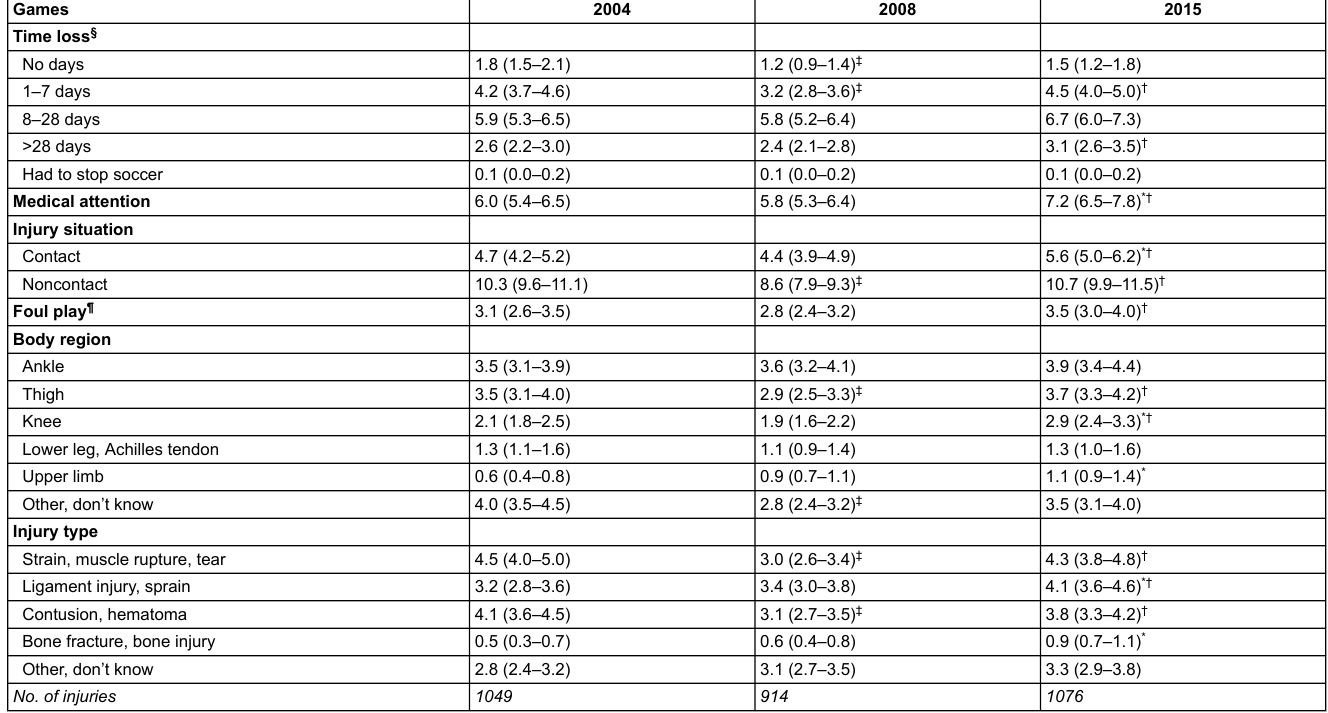
Table 3: Injury incidence in amateur soccer games per 1000 hours of playing during the previous 4 weeks, by causes and characteristics (including 95% confidence intervals).